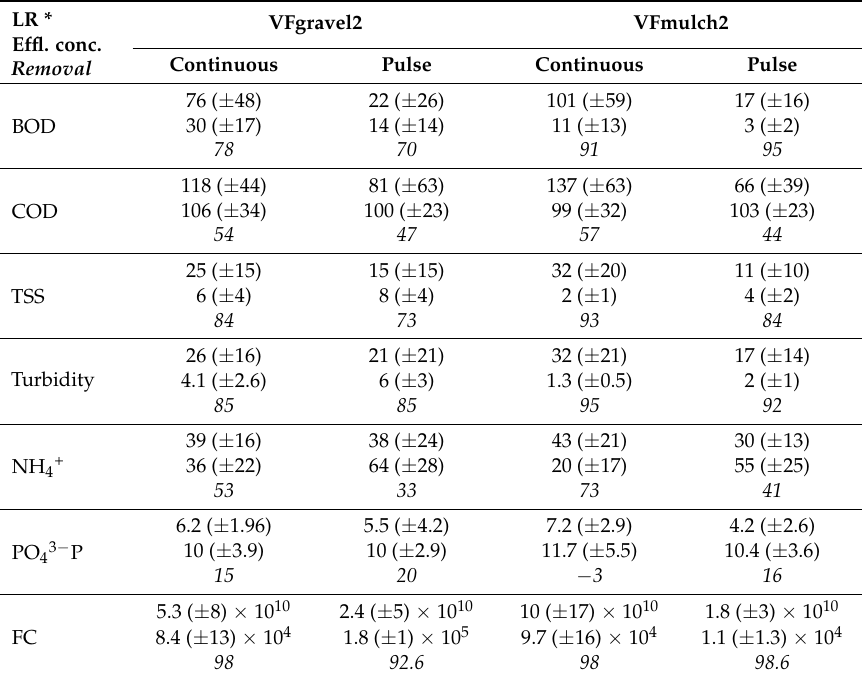
Table 4. Average LR, concentrations in the effluent ( ± standard deviation) and removals (in italics) for VFgravel2 and VFmulch2 in the continuous and pulse feeding periods. LR * Effl.